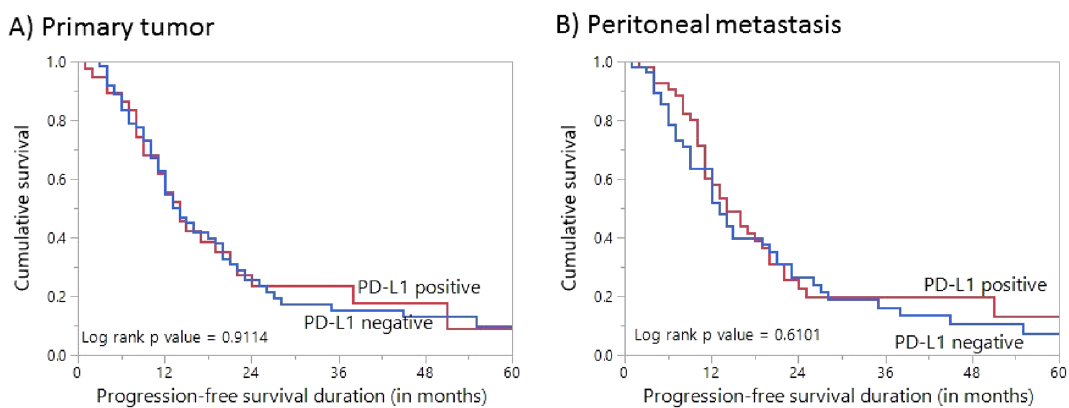
Figure 3. Survival analysis of PD-L1 protein expression in high-grade serous carcinoma. Kaplan Meier survival plot showing no statistically significant difference between PD-L1 positive and negative tumors in both primary ( A ) and corresponding peritoneal metastases ( B ) for progression-free